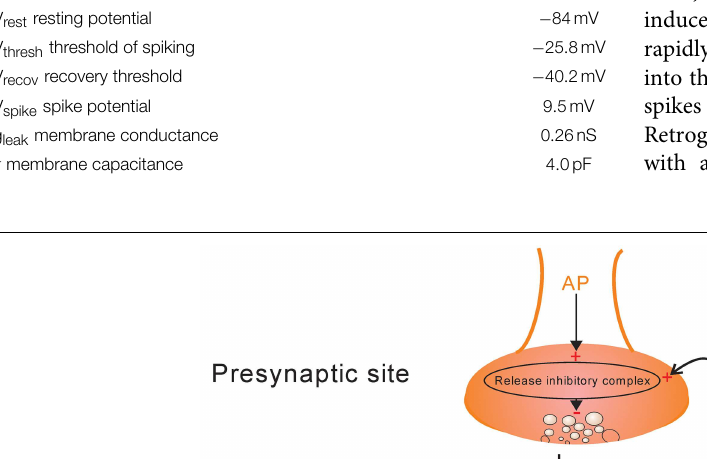
TABLE 1 | Parameters of the integrate and fire neuron model used in this study. Parameter